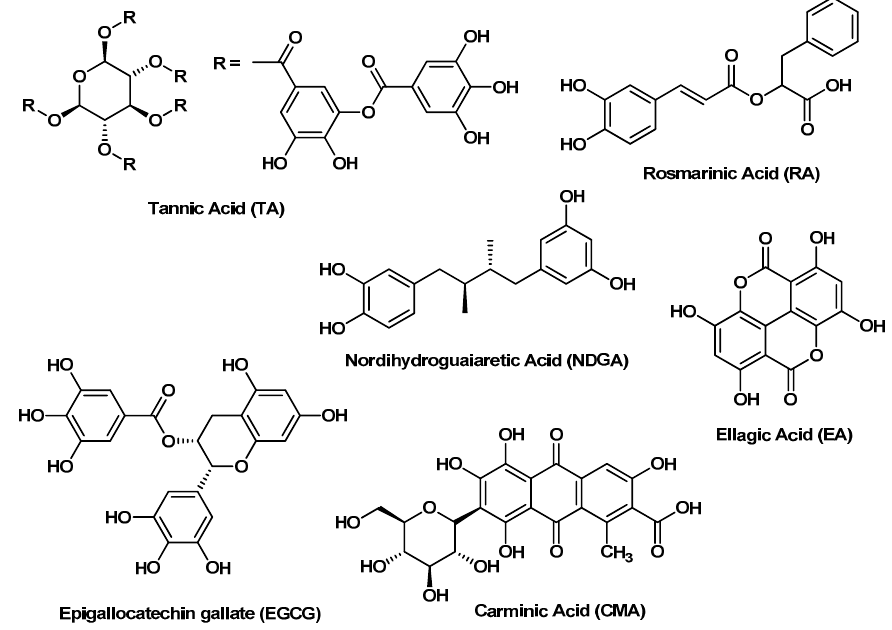
Figure 9. Chemical structure of natural polyphenols employed by Huang Z. et al. [43] for the preparation of injectable dynamic covalent HGs with boronic acid